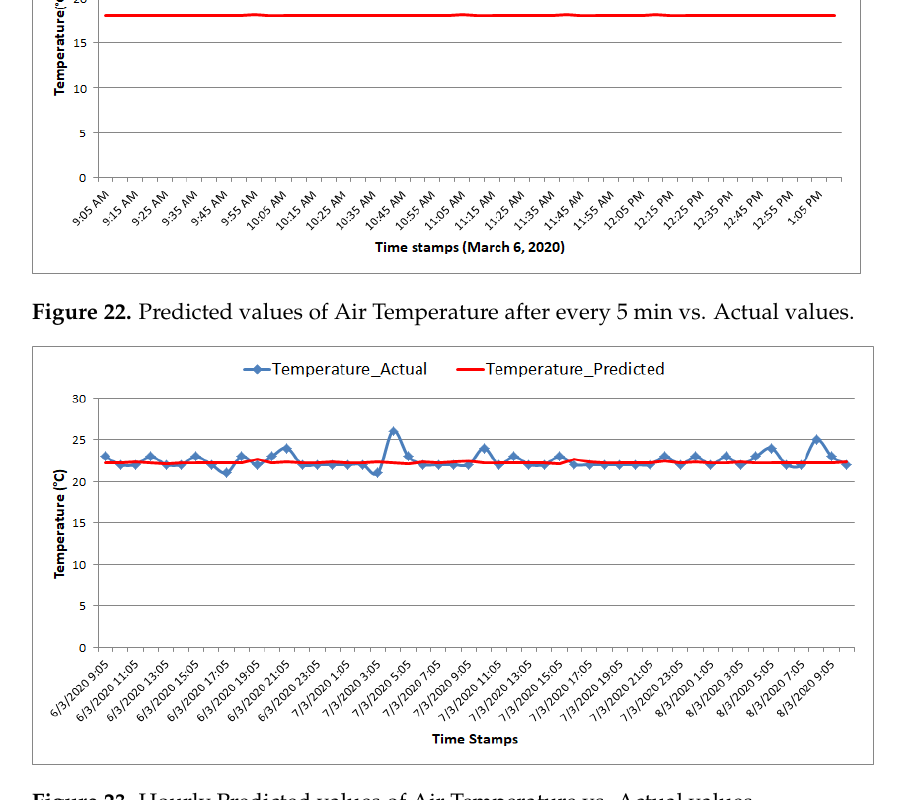
Figure 23. Hourly Predicted values of Air Temperature vs. Actual values.